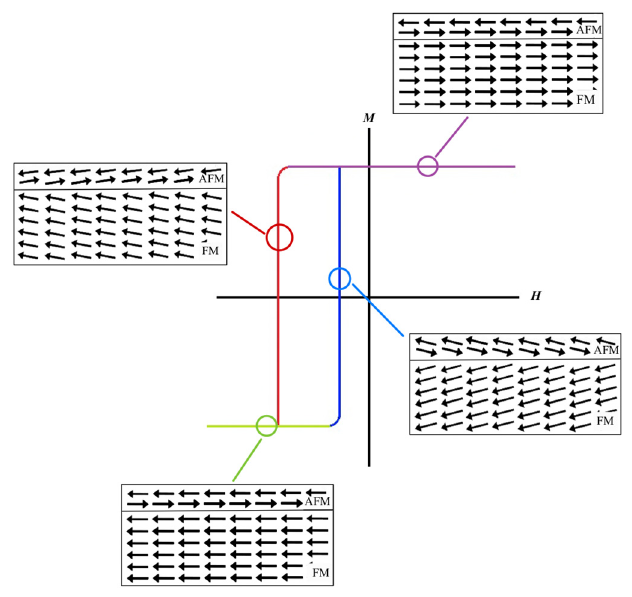
Figure 10. The magnetic moment of PtMn (AFM) and Terfenol–D (FM) associated with different locations on the Terfenol–D hysteresis loop. Note that M represents the magnetization of the FM material.